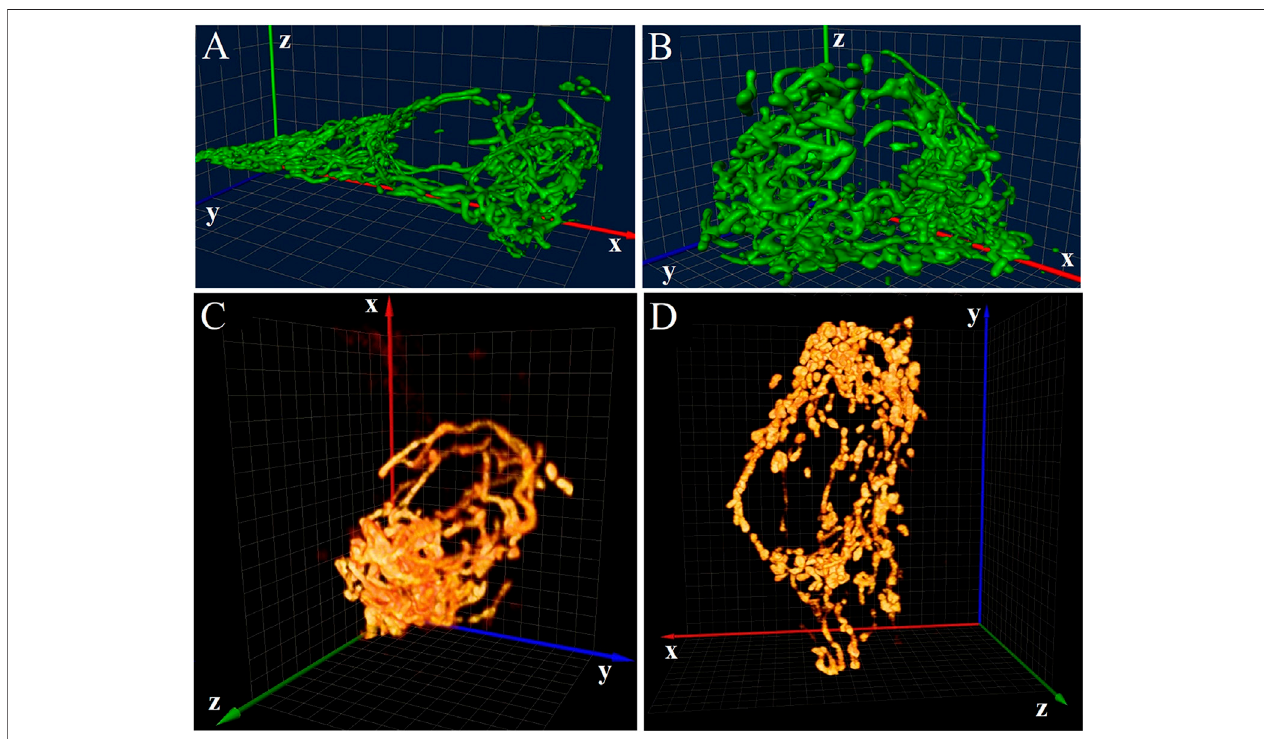
FIGURE 3 | Applications of 4Pi microscopy in 3D imaging. (A) and (B) 4Pi images of the mitochondrial network in 1NS-1E cells cultivated at optimum (A) and decreased (B) glucose conditions. Figures aremodi fi edwithpermissionfromRef.23.Copyright© 2008Elsevier. (C) and (D) 4Piimages ofthemitochondrial networkin islet β -cellsofcontrolWistarrats (C) and diabeticGoto-Kakizakirats (D) .Figuresaremodi fi edwithpermissionfromRef.24.Copyright©2010Elsevier.Thesizeofall3D grids shown in the background is 1 μ m.